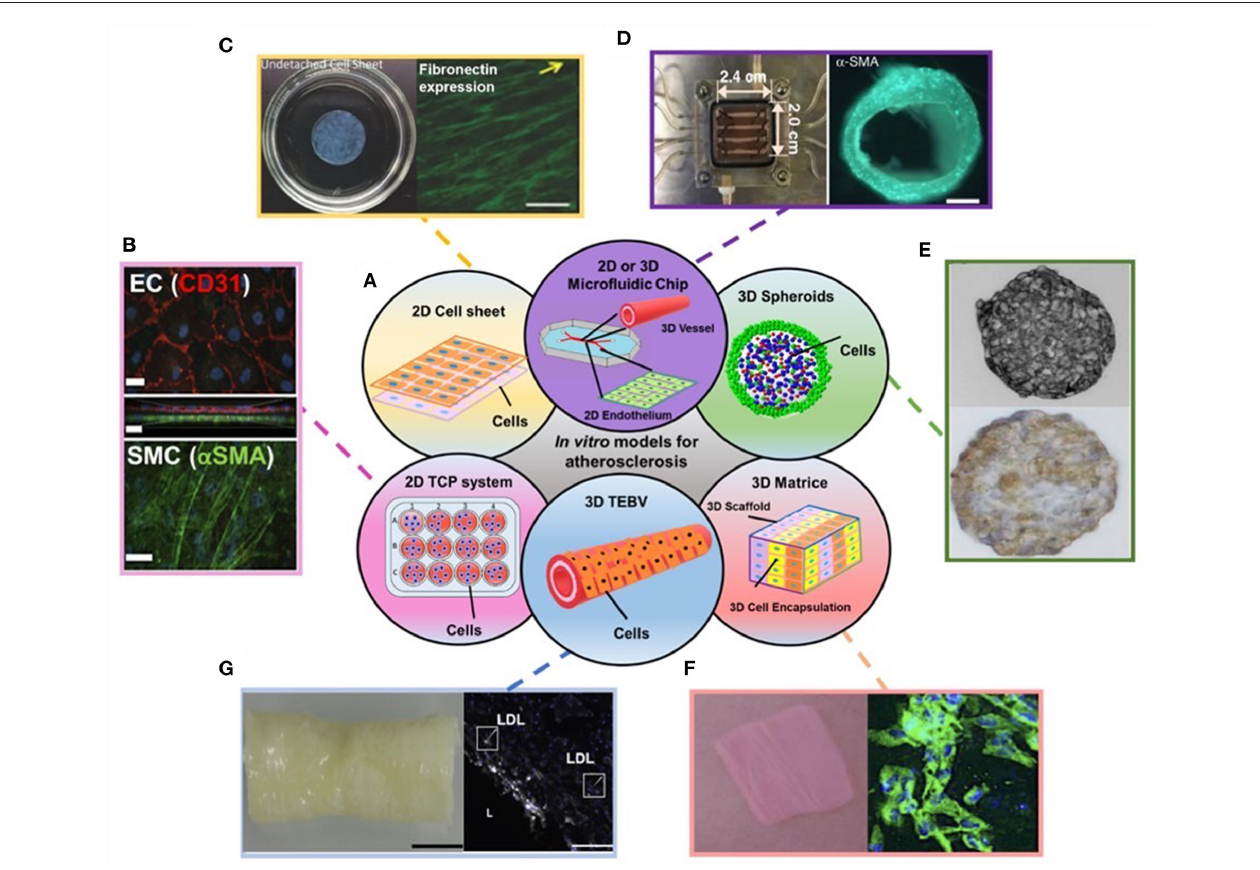
FIGURE 1 | (A) Schematic showing the disused in vitro models for atherosclerosis studies in the review. (B–G) Examples of data regarding different in vitro models covered in the review: (B) Endothelial cells (ECs) (top) and Smooth muscle cells (SMCs) (bottom) stained with EC and SMC phenotype markers in 2D transwell model. (C) 2D cell sheet (left) that expresses fibronectin (right). (D) 3D microfluidic vessel on a chip (left) made of green fluorescence protein-expressing human umbilical vein endothelial cells (right). (E) SMC spheroid (top) and EC/SMC spheroid (bottom). (F) 3D SMC laden hydrogel constructs (left) and stained with SMA- α (right, green). (G) 3D tissue-engineered blood vessels (left) and stained with monocytes and LDL (right). Adapted, with permission from (16) (B) , (17) (C) , (18) (D) , (19) (E) , (20) (F) , and ( 21) (G)